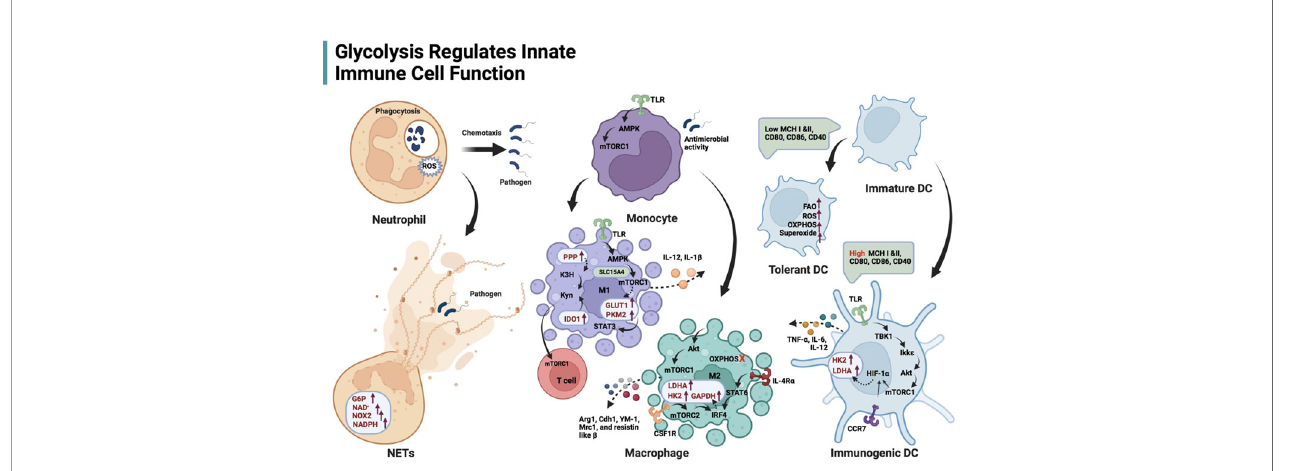
FIGURE 2 | Schematic illustration of glycolysis regulating innate immune cell function. Glycolysis is the main energy production pathway for neutrophils. Impairing glycolysis and PPP can destroy neutrophil function, including chemotaxis and ROS production, even phagocytosis. NETs formation is dependent on adequate glucose fl ux, G6P, NOX2, and NAD + /NADPH. The TLR/AMPK/mTORC1 regulates glycolysis-dependent antimicrobial activity in monocytes. TLR/AMPK/mTORC1 axis is also responsible for M1-type macrophage induction, expression of glycolytic enzymes (GLUT1 and PKM2) in these cells and their IL-12 secretion. Solute carrier family 15 member A4 (SLC15A4) is likely to maintain the interaction of AMPK and mTORC1 by acting as a scaffold. PKM2 in M1 macrophages contributes to IL-1 b transcription via STAT3 signaling. Both enhanced PPP and IDO-1 in M1 macrophages facilitate kynurenine accumulation, stimulating mTORC1 activity in T cells. Akt/mTORC1-mediated glycolysis also affects M2-like macrophage differentiation and gene pro fi le expression (Arg1, Cdh1, YM-1, Mrc1, and resistin-like b ) when OXPHOS in macrophages is inhibited. The interferon regulatory factor 4 (IRF4), which is downstream of the IL-4 receptor a /STAT6 and colony-stimulating factor 1 receptor (CSF1R)/mTORC2 signaling axis, promotes glycolysis (enhanced expression of LDHA, GAPDH and HK2) during M2 activation. DCs activated by TLRs depend on glycolysis fl ux to ful fi ll metabolic and functional requirements, including secretion of TNF- a , IL-6 and IL-12. TBK1/Ikk ϵ -mediated Akt phosphorylation responds to lipopolysaccharide stimulation of TLRs on DCs. p-Akt/mTORC1 immediately promotes the transcription of HK2 and LDHA via HIF-1 a . Cxc chemokine receptor 7 (CCR7)-mediated HIF-1 a induction contributes to DC